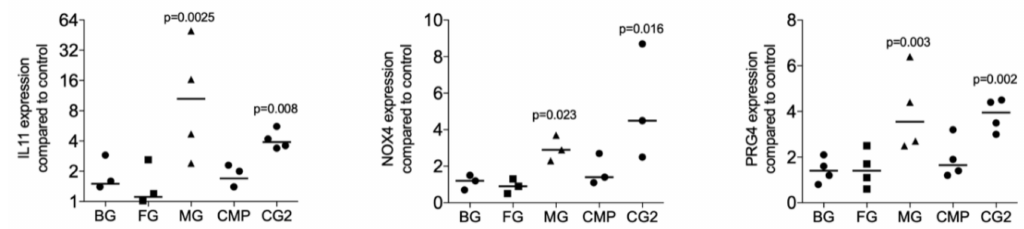
Figure 1. Supernatants of two collagen membranes increase TGF- β target genes.